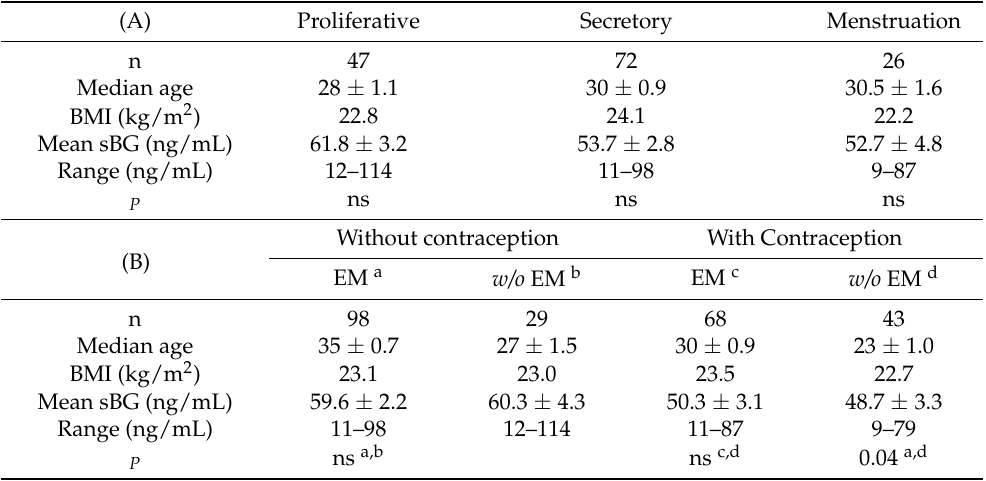
Table 3. Soluble betaglycan levels in